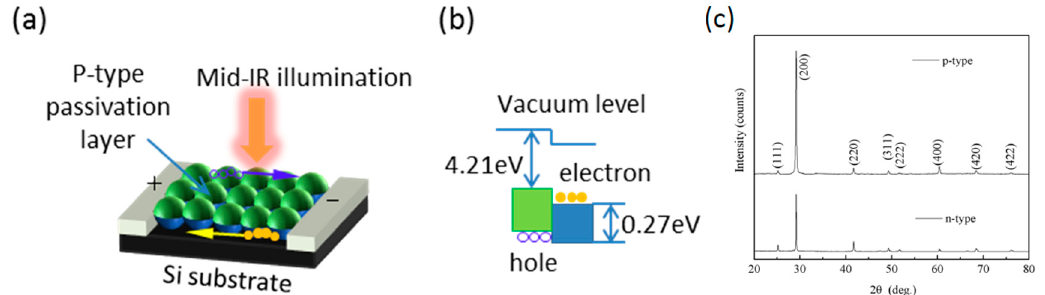
Figure 5. ( a ) A schematic of charge separation under mid-infrared (IR) illumination and ( b ) the corresponding energy diagram in the sensitized PbSe polycrystalline coatings based on electrical conductive type effect, ( c ) the X-ray diffraction (XRD) patterns of n-type and p-type PbSe thin fims. Reprinted with permission from [64]. Copyright Springer 2016.